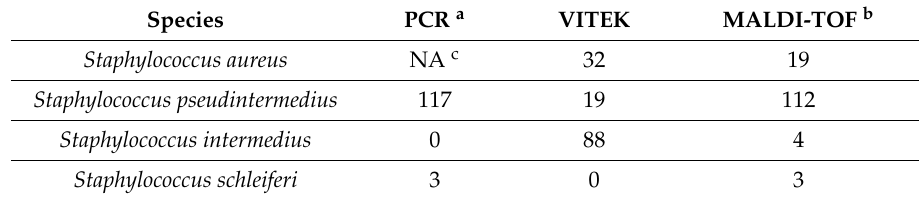
Table 1. Comparison of results of the species-level identification of coagulase-positive Staphylococcus (CoPS) isolates ( n = 139) yielded by multiplex species-specific PCR, VITEK and MALDI-TOF. Species PCR a VITEK MALDI-TOF b Staphylococcus aureus NA c 32 19 Staphylococcus pseudintermedius 117 19 112 Staphylococcus intermedius 0 88 4 Staphylococcus schleiferi 3 0